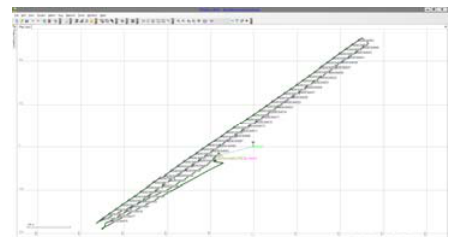
Figure 5: APX-15 UAV trajectory with photo centres - Railway Corridor